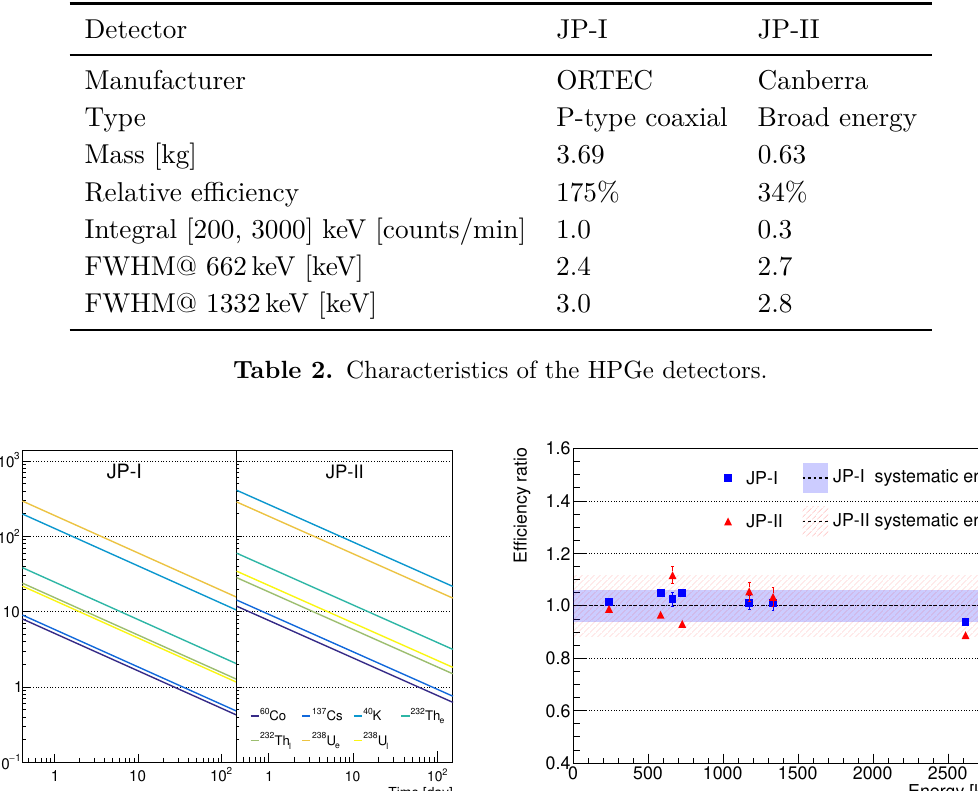
Figure 4. Efficiency ratios of measurement and simulation for JP-I and JP-II HPGe